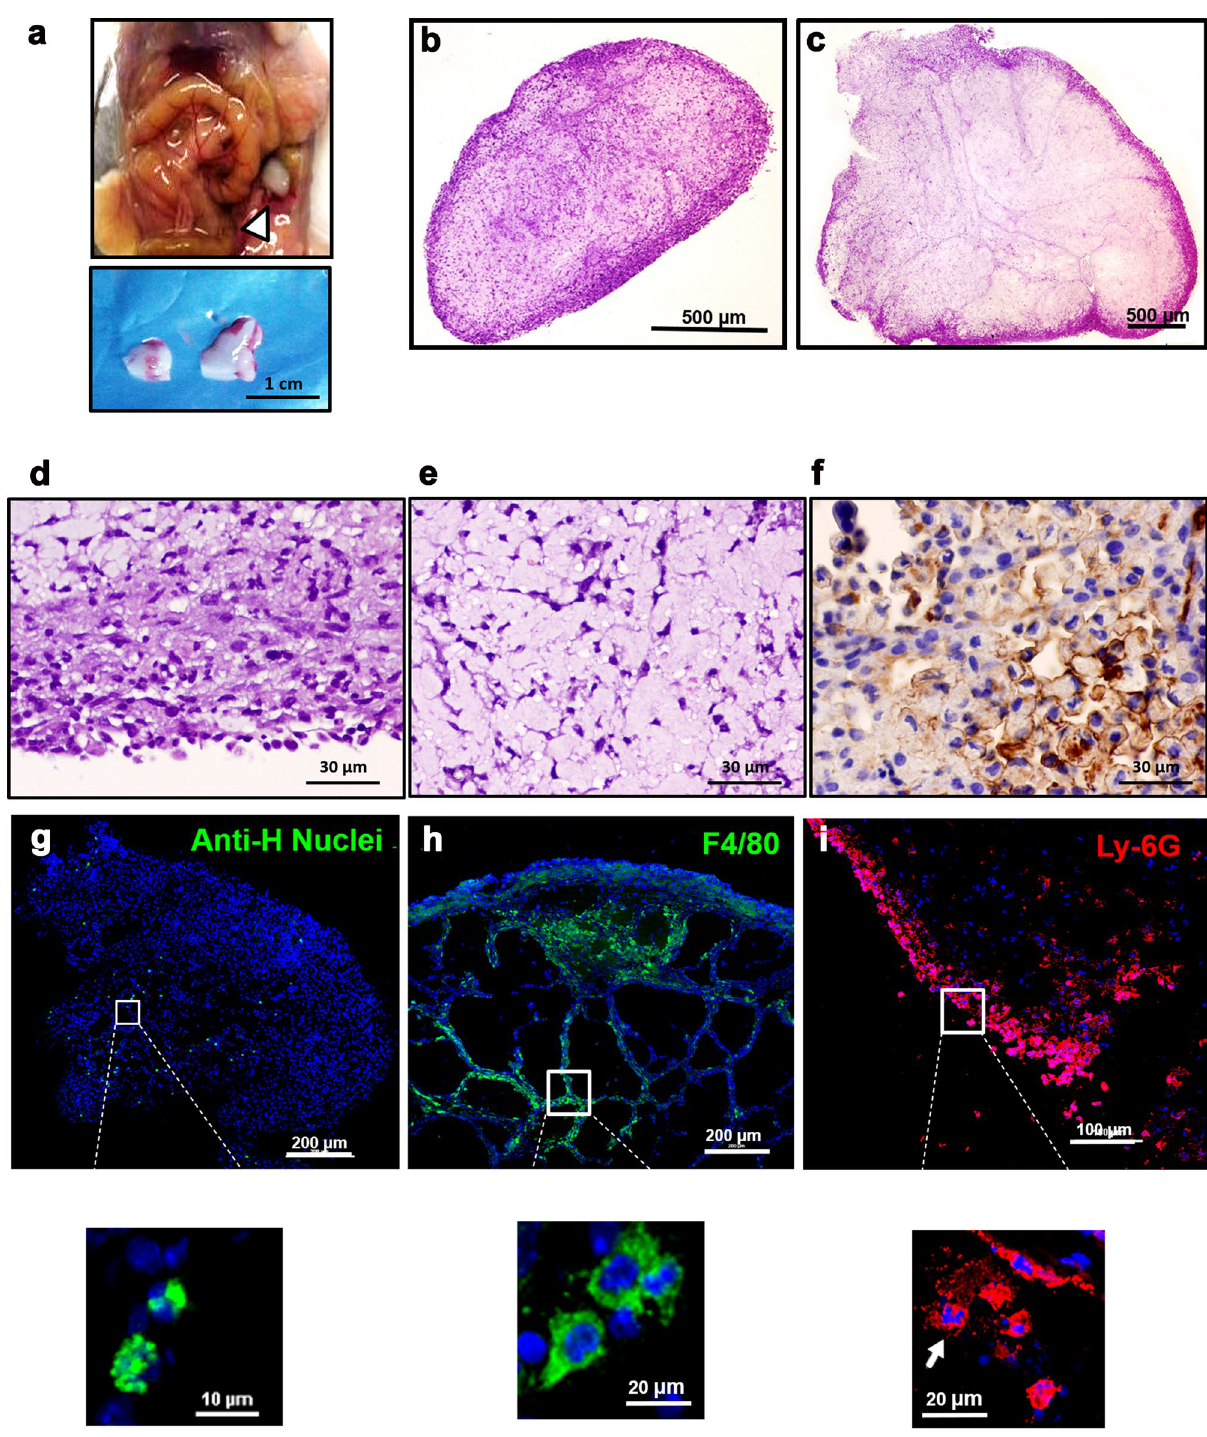
Figure 2. Histopathological evaluation of the nodule generated after T + MenSCs administration. ( a ) Representative image of the nodule. (top, arrowhead) Peritoneum location 3 days after MenSCs administration under the TGC inflammatory insult. (bottom) Nodules recovered from mice injected with TGC + MenSCs-24 h. ( b – f ) Representative images of nodules taken by optical microscopy. ( b ) Longitudinal and ( c ) cross H&E stained sections from a paraffin embedded sample . 20 × magnification of the ( d ) peripheral and ( e ) central area of the structure . ( f ) Human cytokeratin + cells within the aggregates. ( g ) MenSCs, ( h ) macrophage and ( i ) neutrophil populations distributed within the OCT-frozen structure as determined by laser confocal microscopy after staining with the appropriate antibodies: ( g anti-human nuclei + -AF488; h anti-F4/80 + -AF488; i anti-Ly- 6G + -AF594). A total of 3 different nodules were histopathologically